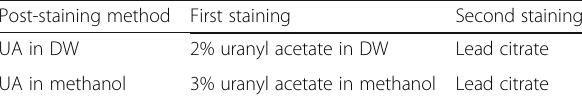
Table 1 Double staining methods Post-staining method First